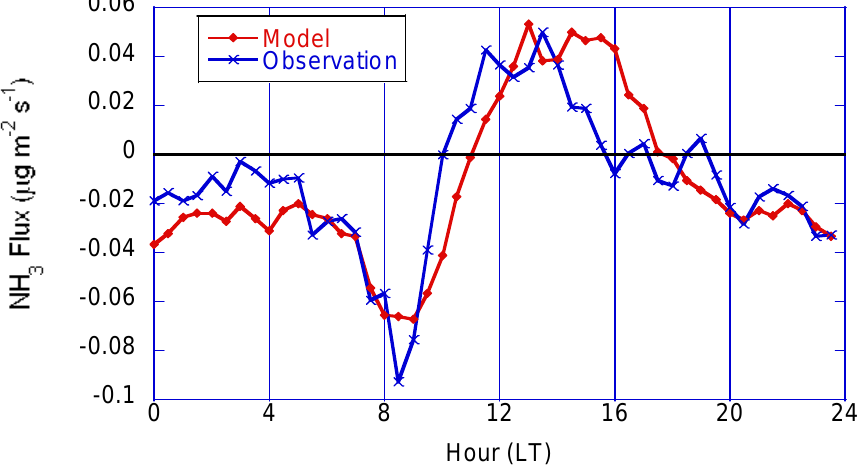
Figure 4. Average ammonia surface flux measured in a soybean field in Warsaw, North Carolina and modeled by the bi-directional flux scheme in the CMAQ model averaged over 2 months in summer